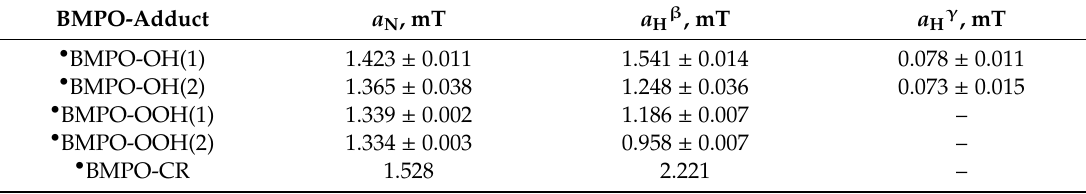
Table 1. Hyperfine coupling constants of the BMPO spin-adducts elucidated from the simulations of experimental spectra measured in the bu ff er solutions containing KO 2 and 10% DMSO ( v / v ). • BMPO-OOH and • BMPO-OH were simulated considering presence of two conformers [15,18,19]. BMPO-Adduct a N , mT a H β , mT a H γ , mT •